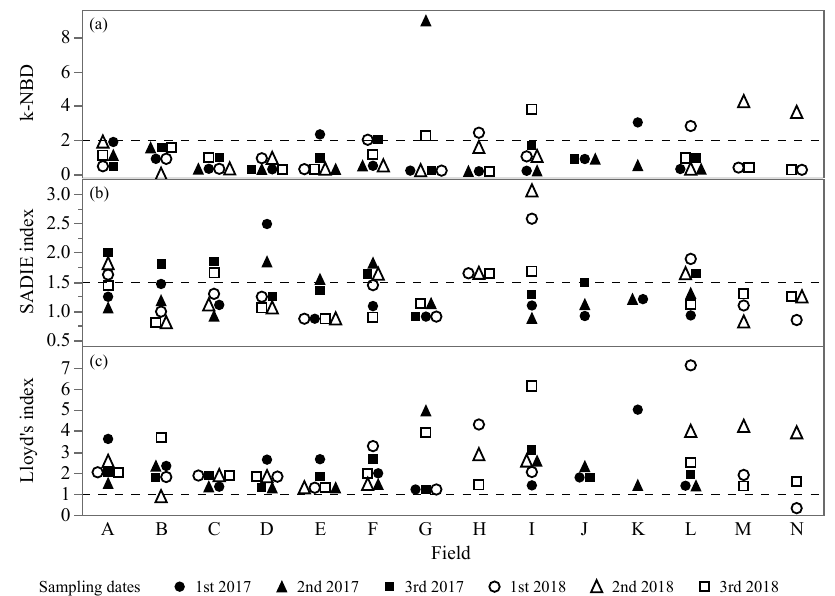
Figure 3. Aggregation indices from adult and larval S. dorsalis count on leaf samples in fourteen blueberry fields in central Florida during the summers of 2017 and 2018. Dashed lines are the break-even points of aggregation indices; the distribution of the counts is aggregated if ( a ) k-NBD (Negative Binomial Distribution) < 2, ( b ) SADIE (Spatial Analysis of Distance Indices) index > 1.5, and ( c ) Lloyd’s index >